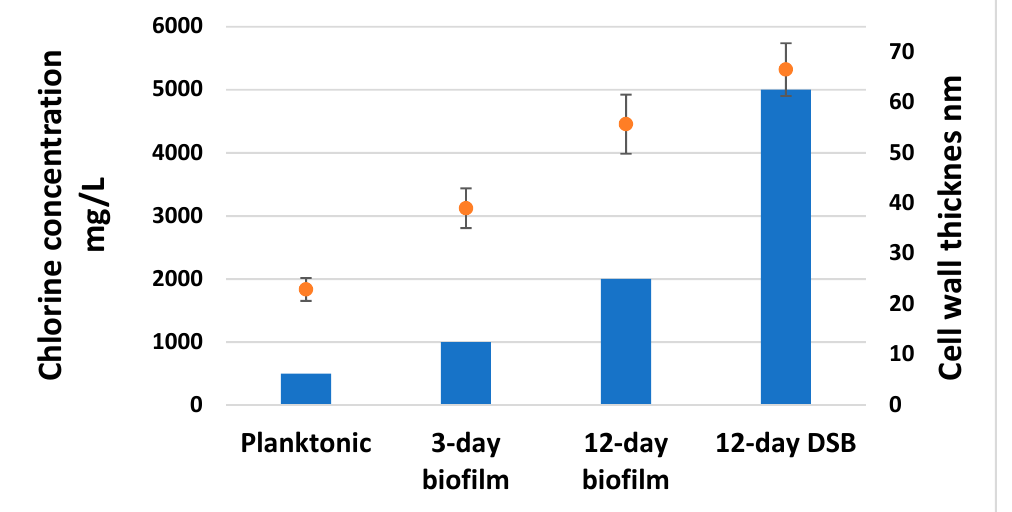
Figure 6. The concentration of available chlorine (column graph) necessary to kill 10 7 S. aureus planktonic, hydrated 3-day, and 12-day biofilm, and dry surface biofilm cells (DSB) and corresponding cell wall thicknesses (mean ± std) (orange dot and